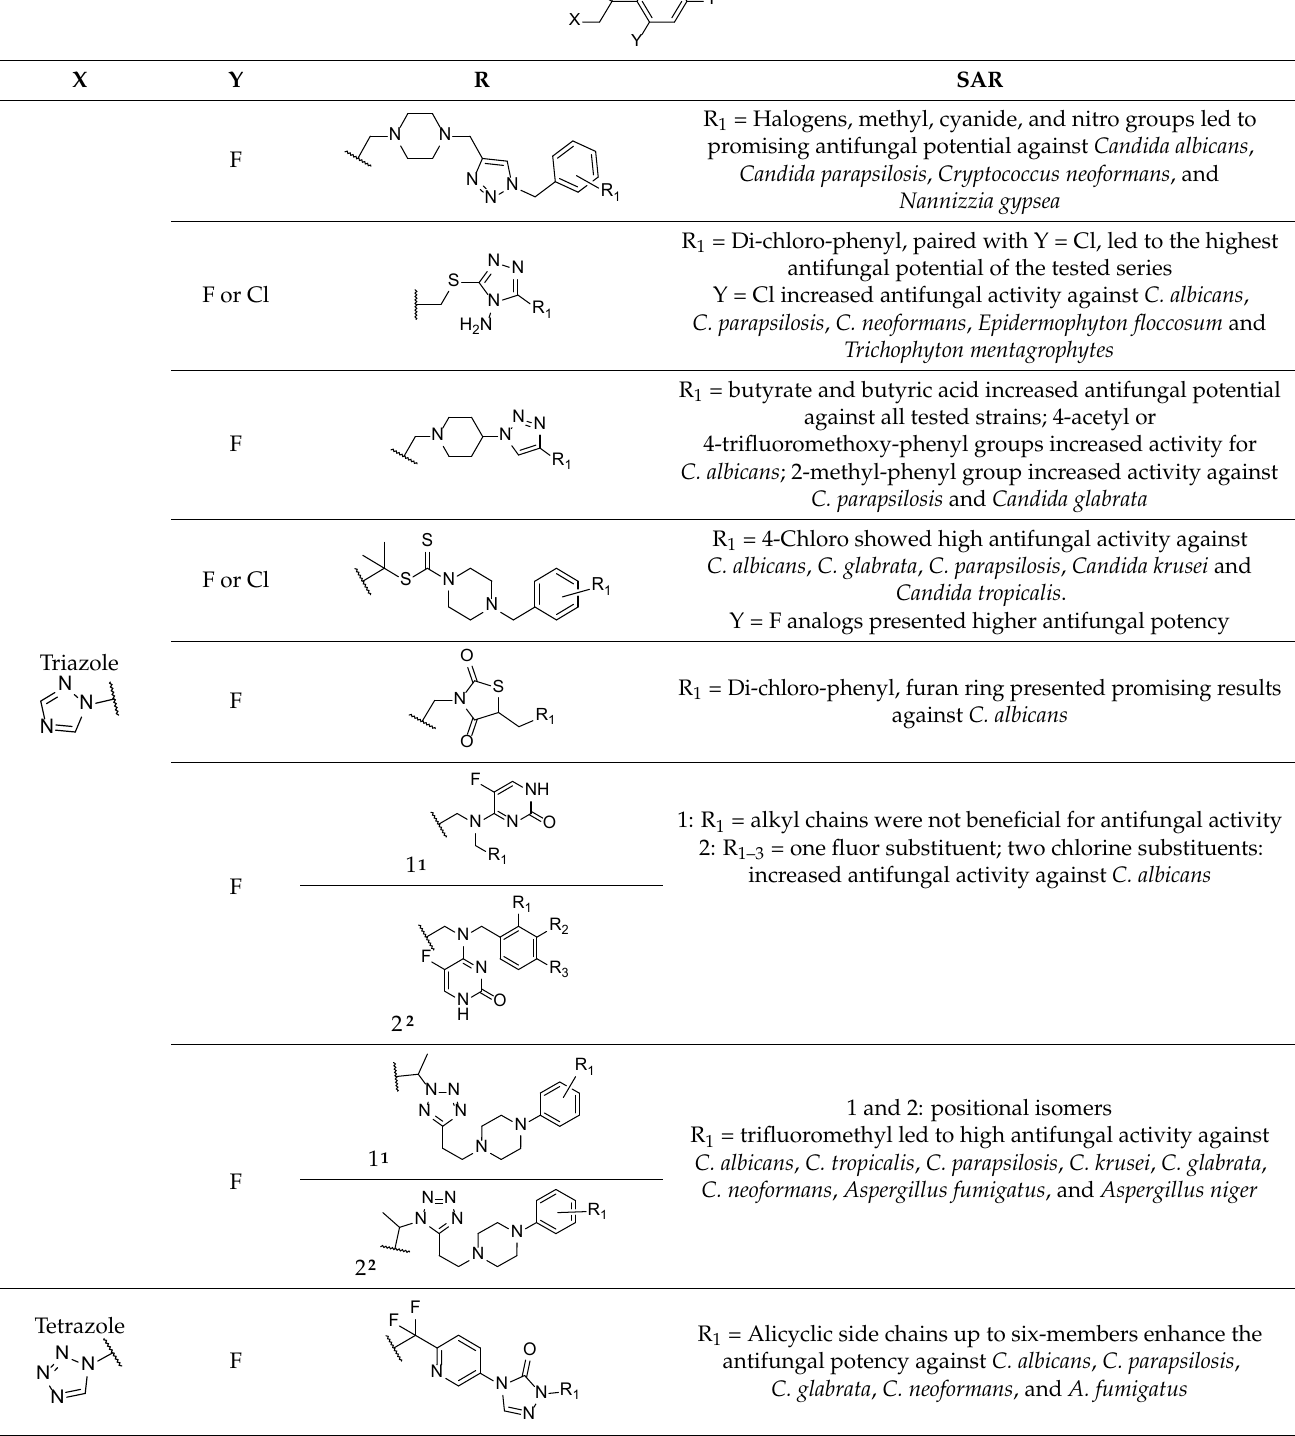
Table 7. Compilation of favorable substitutions and SAR for triazole and tetrazole molecules with a traditional azole pharmacophore.